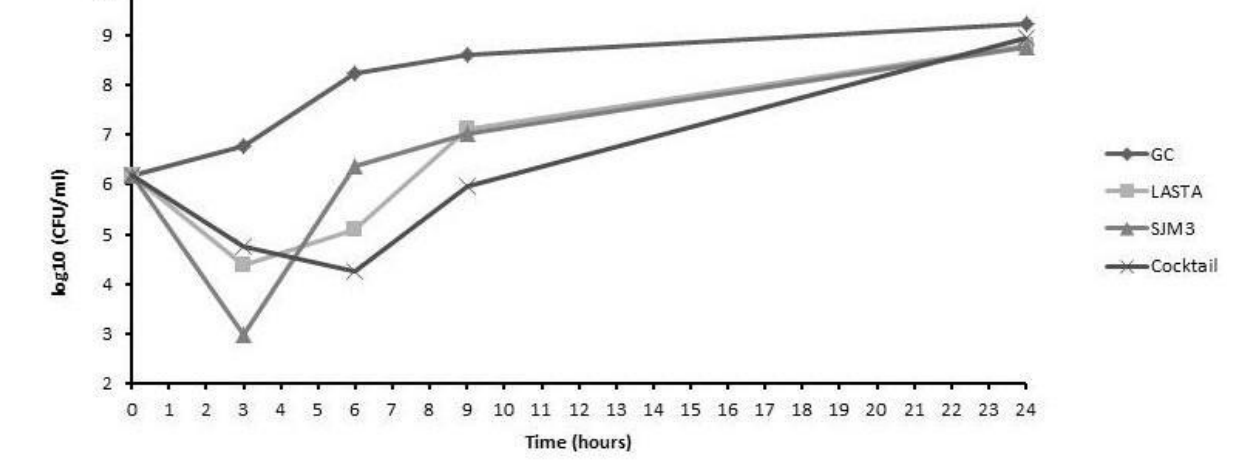
Figure 8. Bacterial cell counts after treatment of planktonic culture of K. pneumoniae Ni9 with bacteriophages LASTA, SJM3 and a cocktail of both phages. Independently applied phages achieved the best result after 3 h, yielding a reduction of 2.38 (LASTA) and 3.81 (SJM3) log units in CFU number compared to the untreated control. Phage cocktail performed best after 6 h, lowering CFU count by 3.99 log units. GC: growth control without phages. N = 3.